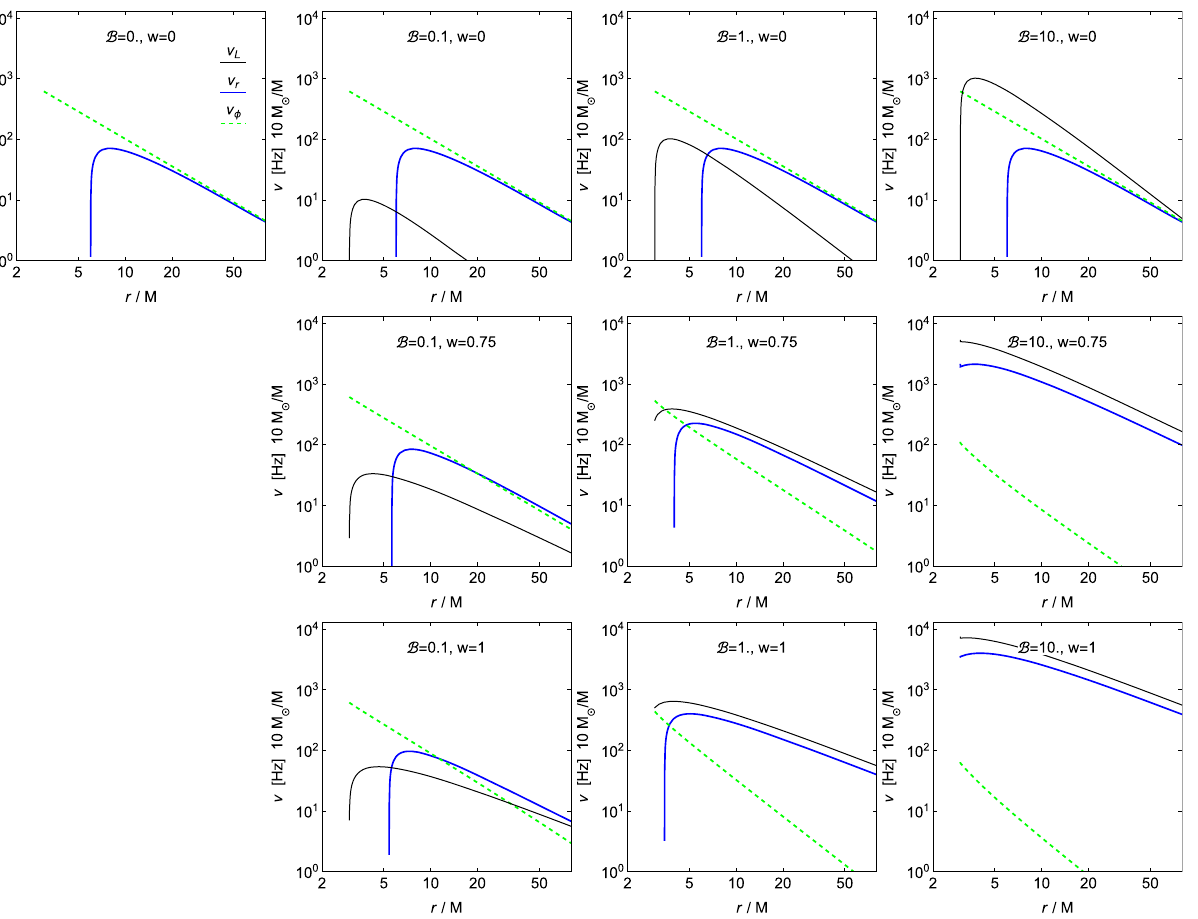
Fig. 15 In-equatorial radial profiles of the frequencies of small harmonic oscillations ν r , ν φ , and ν L of charged particle orbiting BH of the mass of M = 10 M (cid:4) in external parabolic MF for different values of the parameters B and w